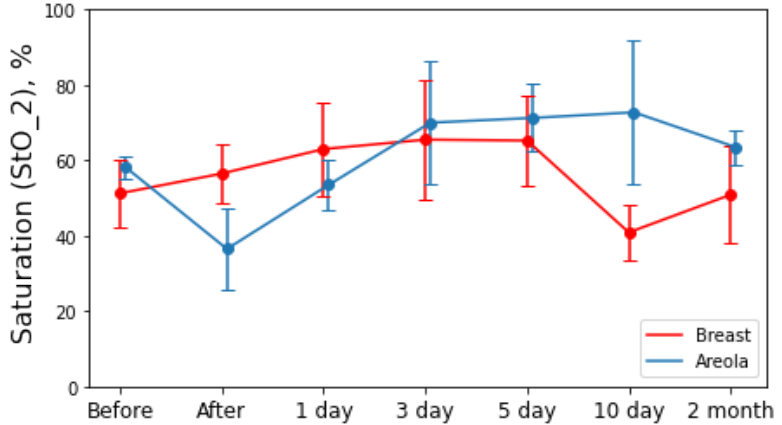
Figure 7. Changes in indicators of optical-spectral control of tissue oxygen saturation: all obtained StO 2 values of each patient, measured on key days before and after surgery.